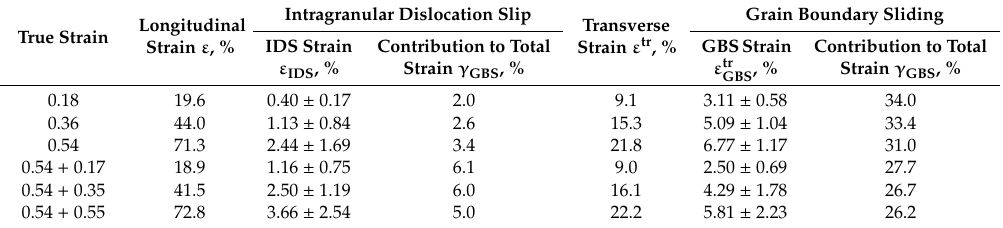
Table 2. Contributions of grain boundary sliding (GBS) and intragranular dislocation slip (IDS) to the total strain during superplastic deformation at 490 ◦ C and 2 × 10 − 4 s − 1